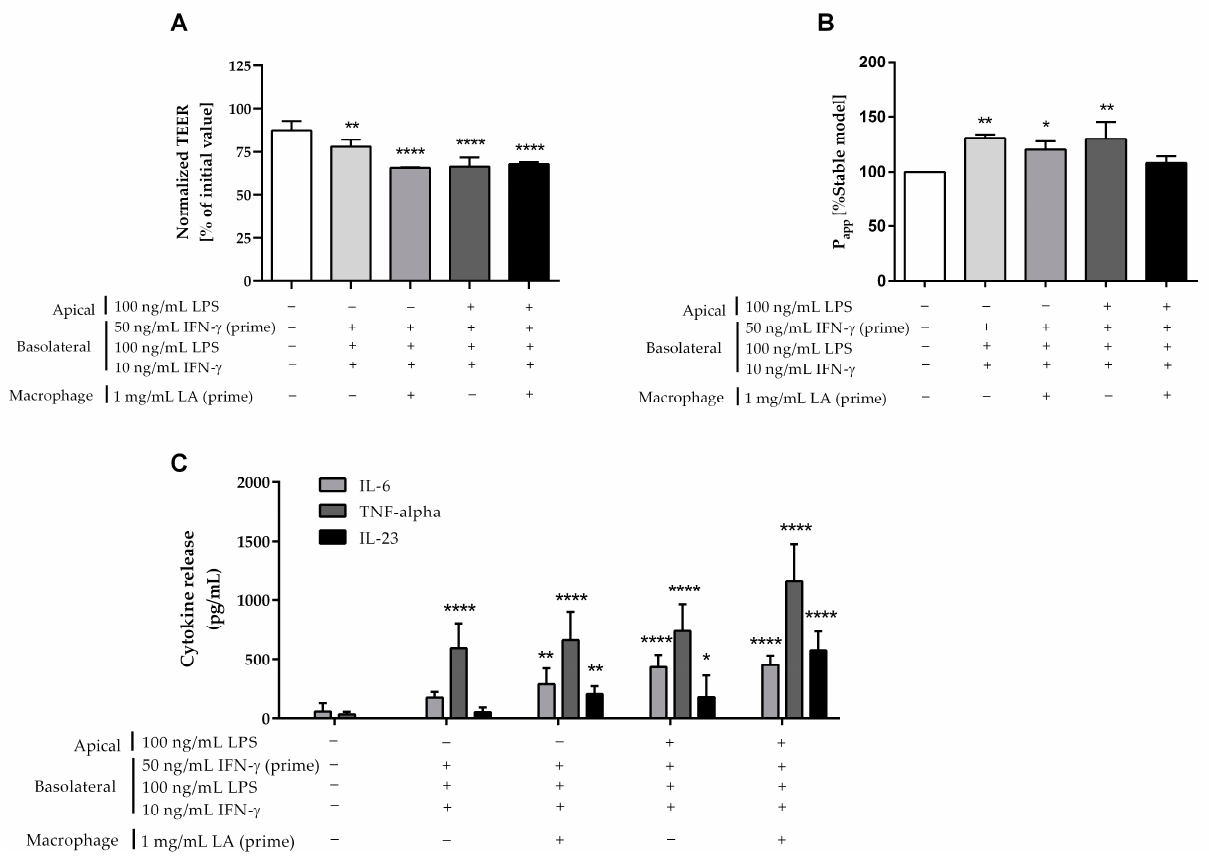
Figure 7. Comparison of the modifications on the “leaky gut” model using primary human-derived macrophages (“ − ”: non-treatment, “+”: treatment). Intestinal barrier function in comparison to the control model was assessed after 24 h by ( A ) TEER and ( B ) permeability values. ( C ) The secretion of key pro-inflammatory cytokines IL-6, IL-23, and TNF- α in the basolateral compartment of control and “leaky gut” models were quantified after 24 h. Bars are mean ± SD ( n ≥ 3). * p < 0.05, ** p < 0.01, **** p < 0.0001 as compared to the control model.